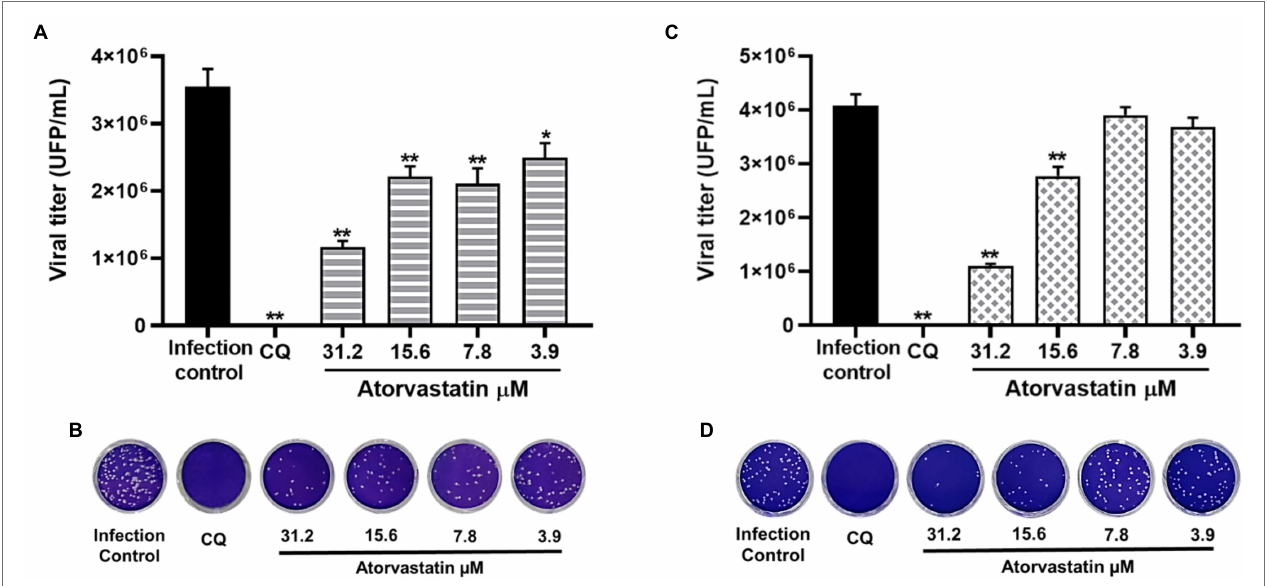
FIGURE 5 | The antiviral effect of Atorvastatin was independent of the infecting SARS-CoV-2 variant. (A) Reduction of Delta variant titer (PFU/ml) in Vero E6 supernatants after pre-post treatment with ATV ( n = 4). (B) Representative plaques of ATV treatment against the SARS-CoV-2 Delta variant are shown. (C) Reduction of Mu variant titer (PFU/ml) in Vero E6 supernatants after pre-post treatment with ATV ( n = 4). (D) Representative plaques of ATV treatment against the SARS-CoV-2 Mu variant are shown. Chloroquine (CQ) was used as a positive inhibition control. Data were presented as Mean ± SEM. Mann–Whitney test * p ≤ 0.05 and ** p ≤